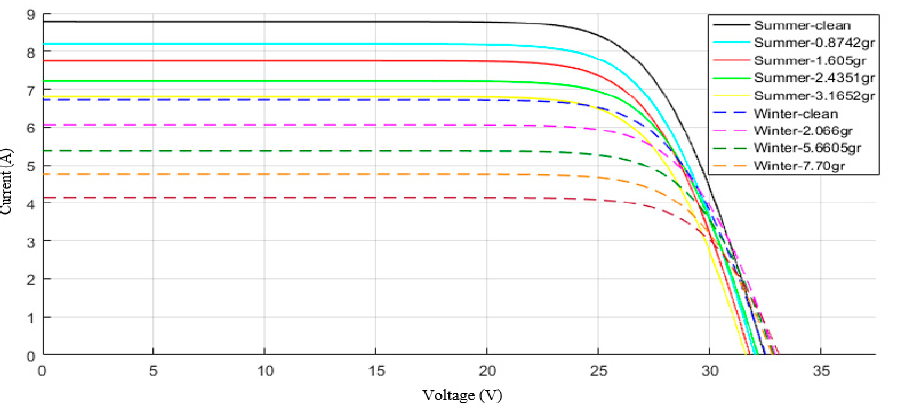
Figure 18. V-I changes for the dust deposited on the panel surface with 35 ◦ angle. It is cleared from Figure 18, that the most important parameter affected by this natural factor is short-circuit current. As the amount of deposited dust increases, the amount of lost current also increases. Because the short-circuit current is due to the generation and accumulation of light carriers, which are actually obtained by photon absorption and the creation of electron-hole pairs. As the accumulation of dust on panel surface prevents light absorption by solar cells that leads to light-generated carries decrement, the short-circuit current decreased. Similar measurements are made for the horizontal panel. Accumulated dust during one month is 3.1652 g and 10.4955 g for summer and winter, respectively. The notable difference is the variation in the amount of dust deposited on the horizontal panel and 35 ◦ angle panel because of gravity impact on the installation angle. This has led to a reduction in the amount of sunlight absorbed by the panel and effect on its voltage-current. Figure 19, shows the variations of these two main parameters for the horizontal panel for the amount of deposited dust.